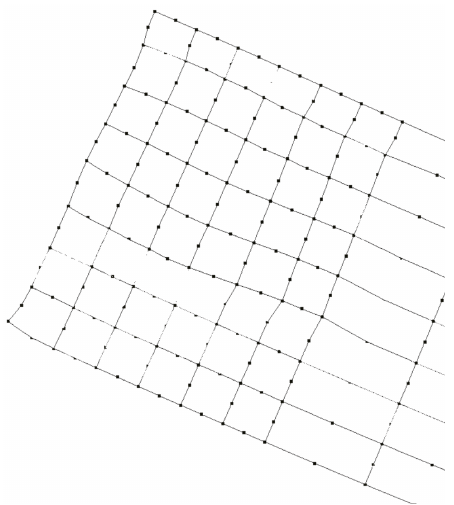
Figure 17. Deformation capture by image